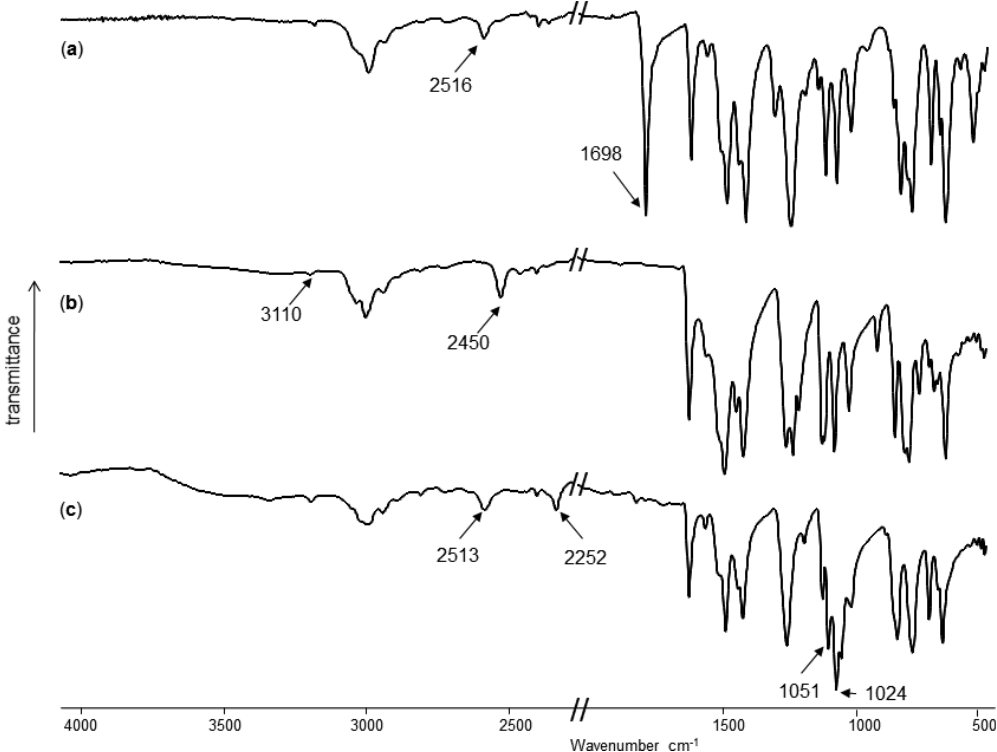
Figure 2: IR (ATR) spectra of (a) [( μ -Me